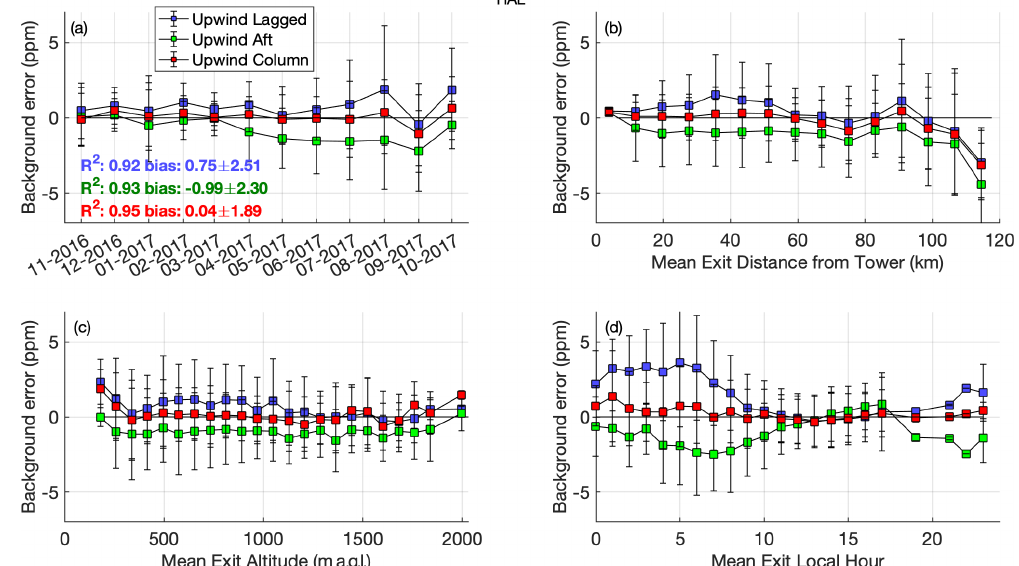
Figure 4. Results of the synthetic data study. Error in background (constructed background–true background) at HAL (afternoon hours only) for each method of using upwind site observations described in the text. Results for the other urban towers are similar. Red points indicate the column-based background (upwind column); green from sampling upwind sites at the same time as urban sites (upwind aft); blue from sampling upwind sites at the time of the particle exit (air mass entrance) earlier in the day (upwind lagged). Text in (a) indicates the coefficient of determination ( R 2 ) and mean bias ± 1 standard deviation of the error over the entire year for each method in the corresponding colors. (a) Monthly mean, (b) binned by mean particle exit distance from the closest upwind tower, (c) binned by mean exit altitude, and (d) binned by mean exit time of day. Error bars are standard deviations.